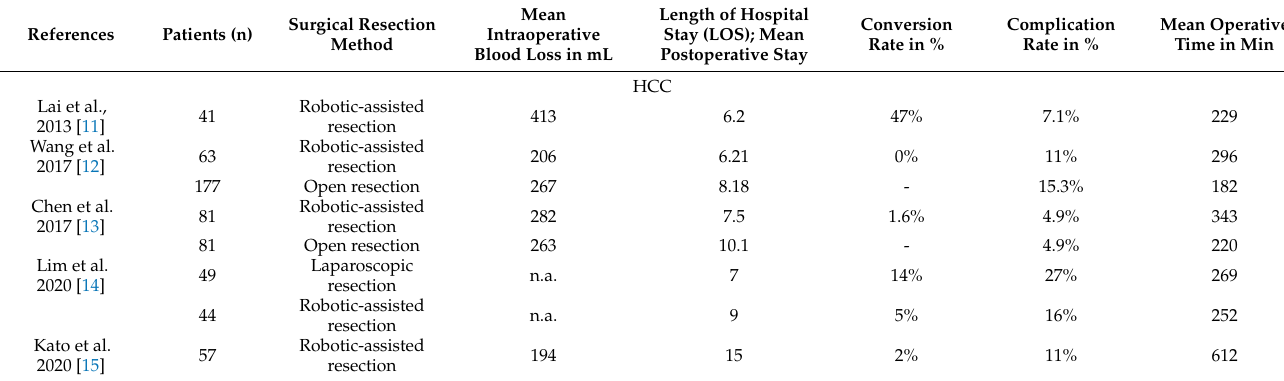
Table 2. Surgical outcome of HCC patients after liver